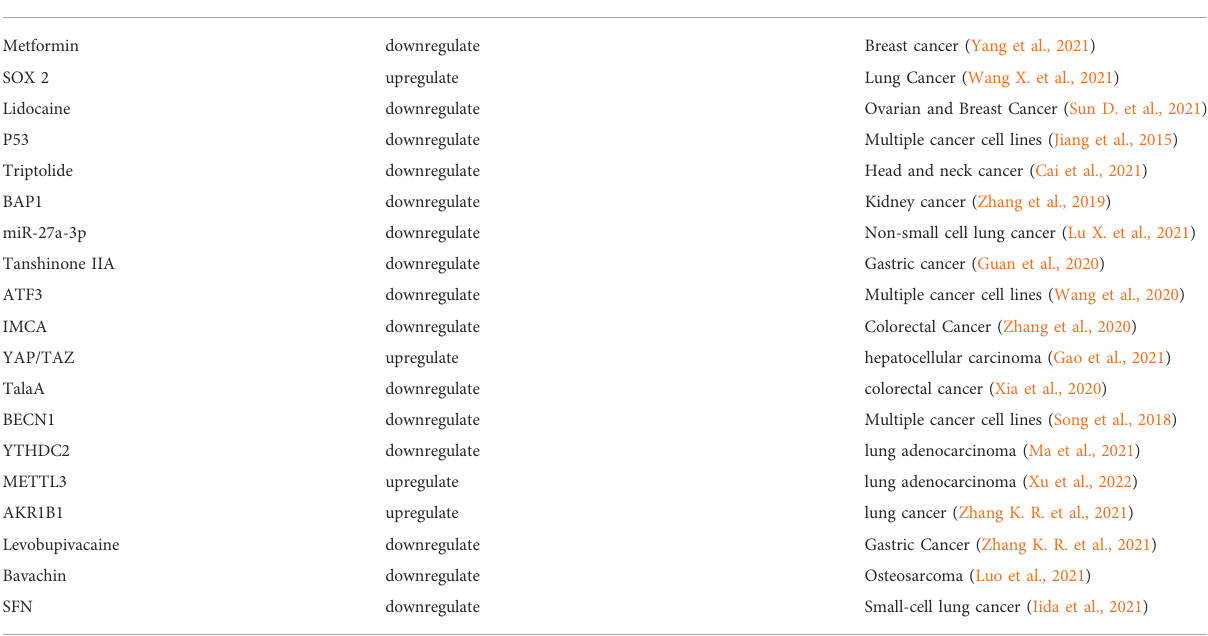
TABLE 1 Regulatory factors of SLC7A11.